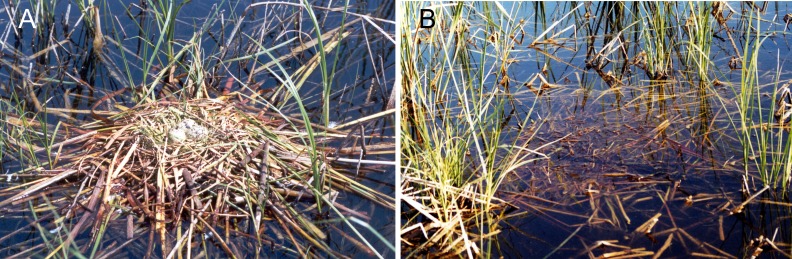
A nest of Whiskered Tern of high quality that was destroyed by the water level fluctuation.(A) Nest with three eggs with a high quality over macrophytes; (B) nest destroyed by the rise of water level fluctuation.